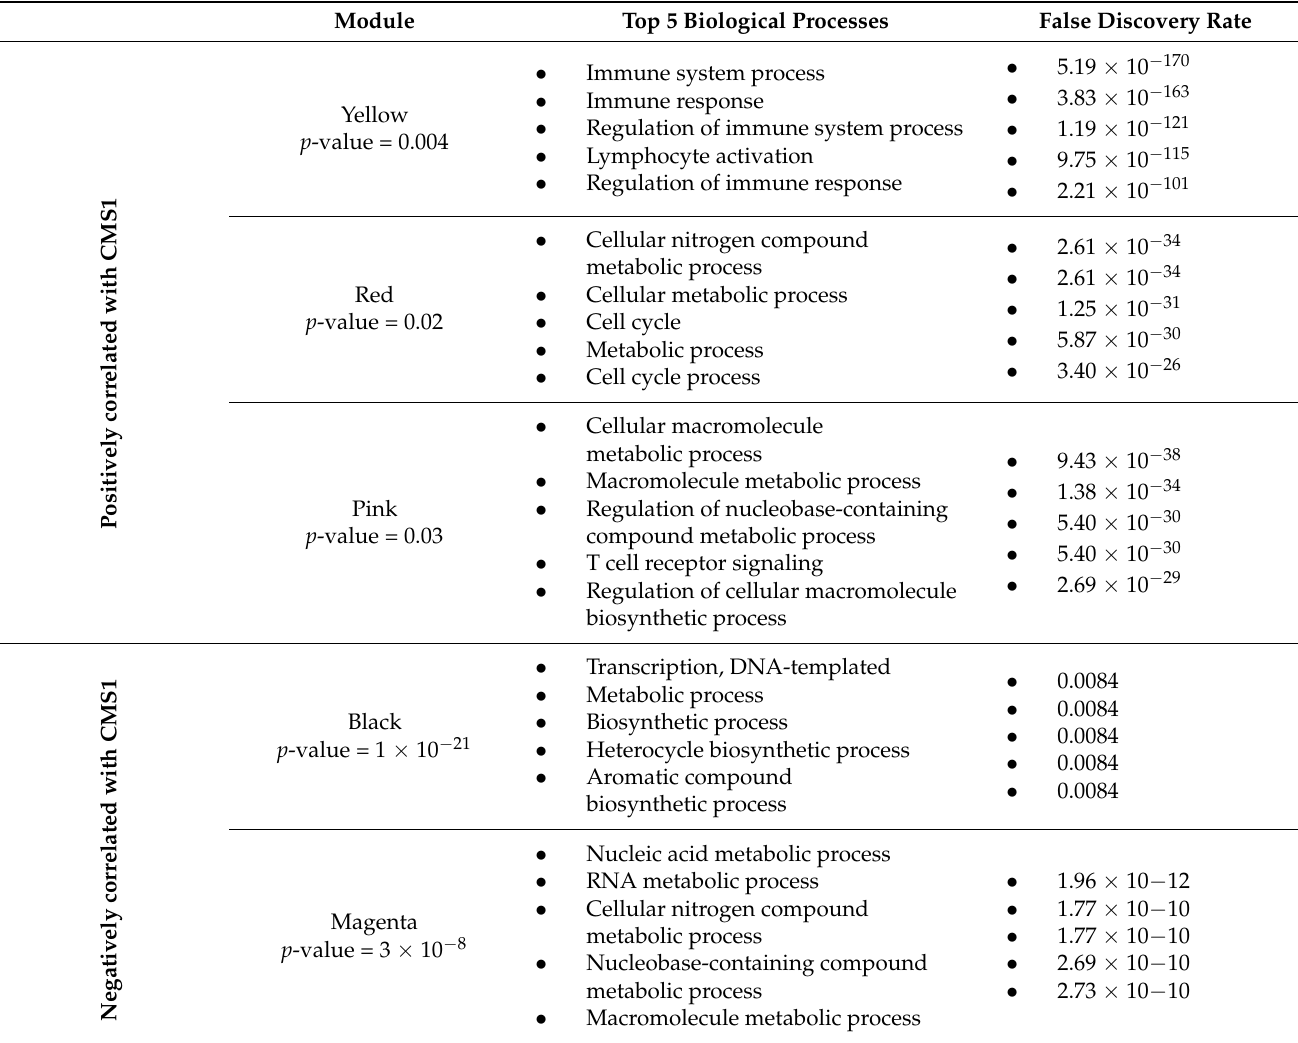
Table 1. Biological processes of module associations for CMS1. Gene Ontology (GO) elite analysis was used to determine the top 5 biological processes of each module positively associated with CMS1 compared to modules that were negatively associated with